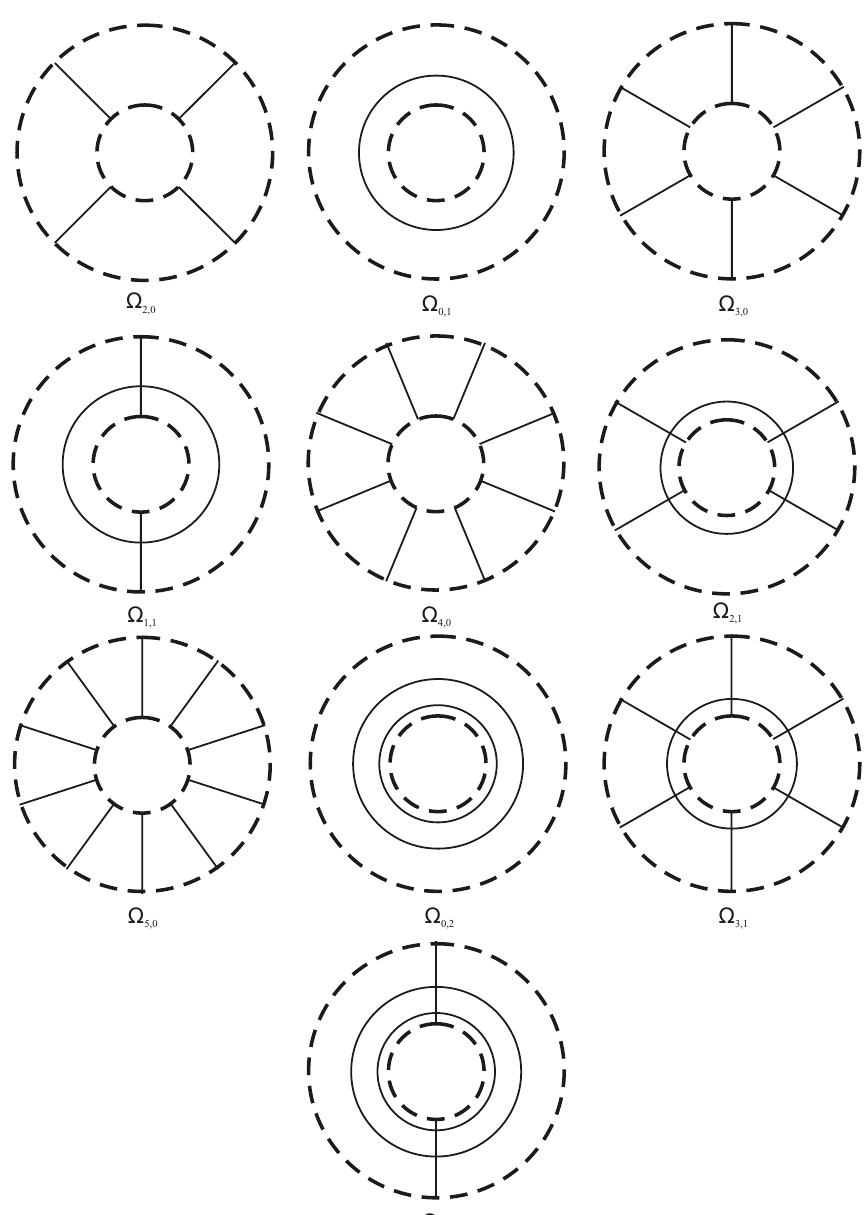
Fig. 8. First ten nodal lines of F - F plates when α = β = 0.4, e r = g r = 5.0, R = 0.5, K f =